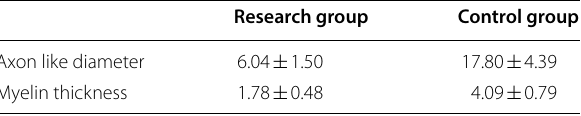
Table 1 Morphological parameters of femoral nerve in research and control groups